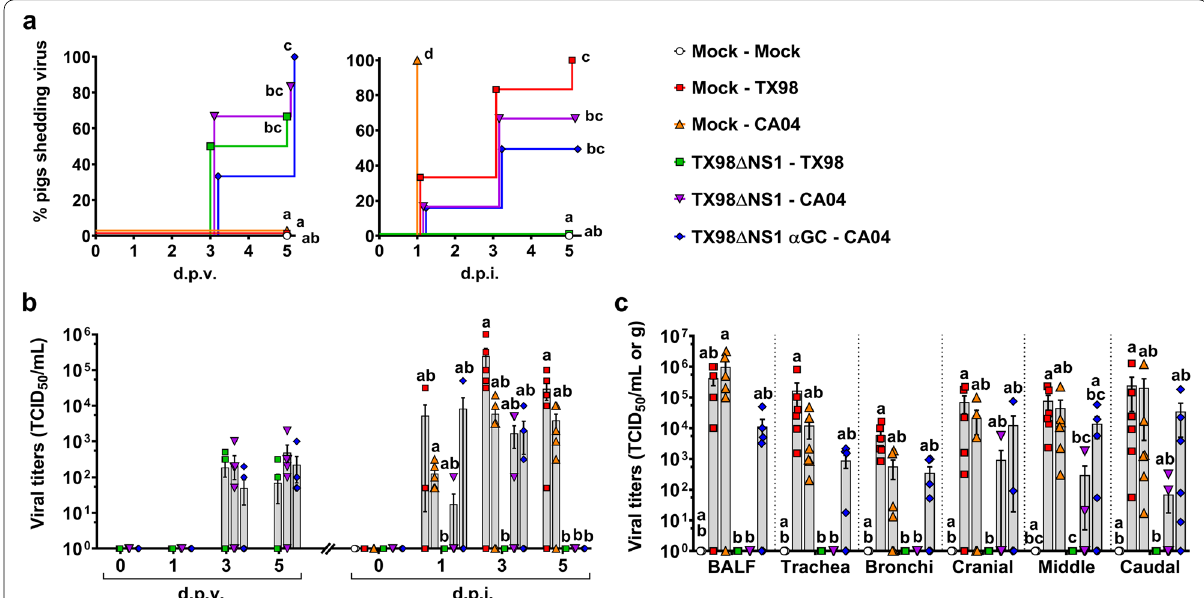
Fig 5 Viral titers in nasal swabs and respiratory tissues. a Percentage of pigs positive for virus shedding in nasal swabs collected at 0, 1, 3, and 5 d.p.v. and 0, 1, 3, and 5 d.p.i.. b Virus titers in nasal swabs after vaccination and infection. c Virus titers in BALF and homogenized respiratory tissues at 5 d.p.i.. Data are represented as TCID 50 /mL for nasal swabs and BALF and TCID 50 /g for respiratory tissues. Differences between treatments were analyzed by Mantel-Cox log-rank test ( a ), or Dunn’s multiple comparisons test ( b , c ). A statistically significant difference between two groups is indicated by different letters. Data are represented as mean SEM. Symbols represent treatment groups ( a ) or individual pigs ( b , c ±